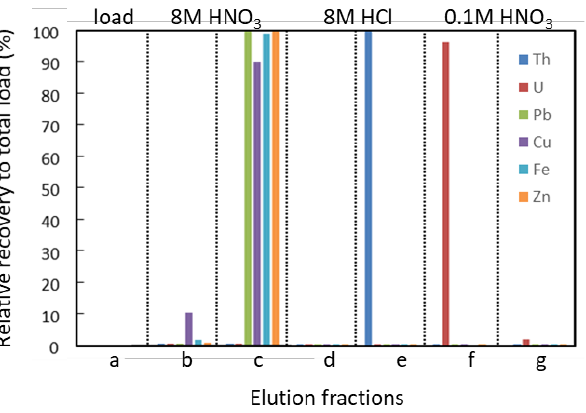
Figure 2. Relative recovery (measured vs. loaded) and elution fractions for the standard SS-1.